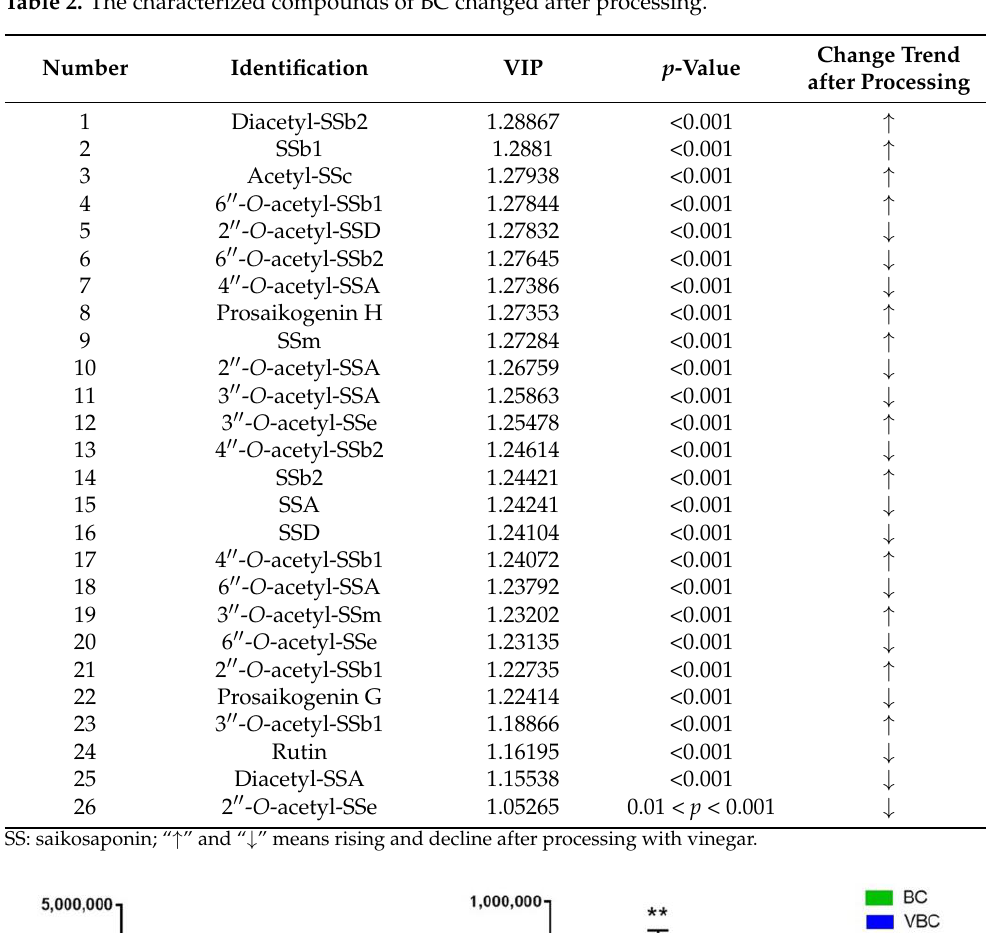
Table 2. The characterized compounds of BC changed after processing.